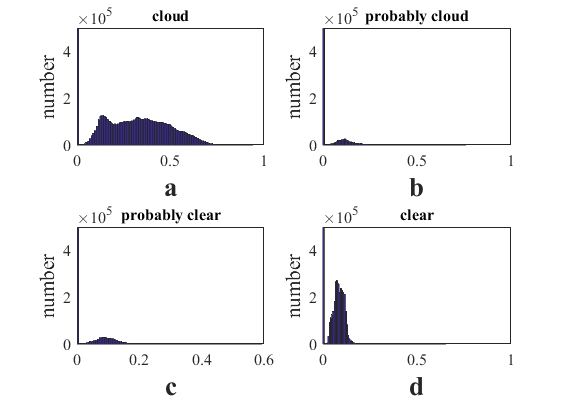
Figure 1. The numerical distribution of R0.65. Figures a, b, c, and d are the numerical distributions of R0.65 in the case of “cloud”, “probably cloud”, “probably clear”, and “clear”.